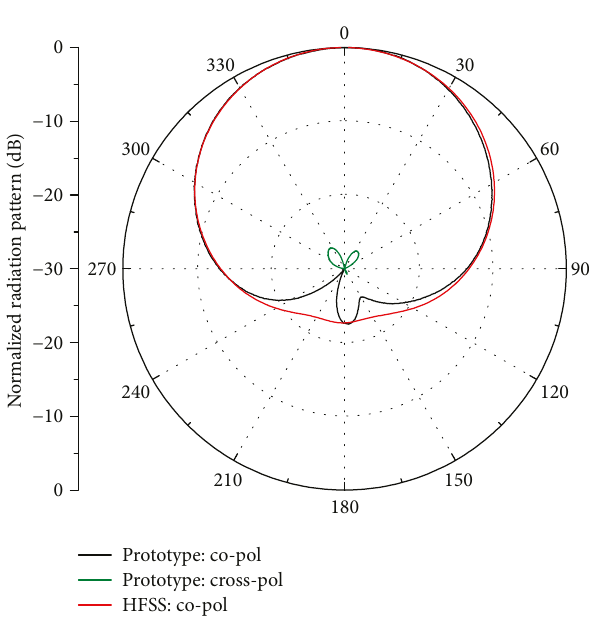
Figure 28: Normalized H plane radiation